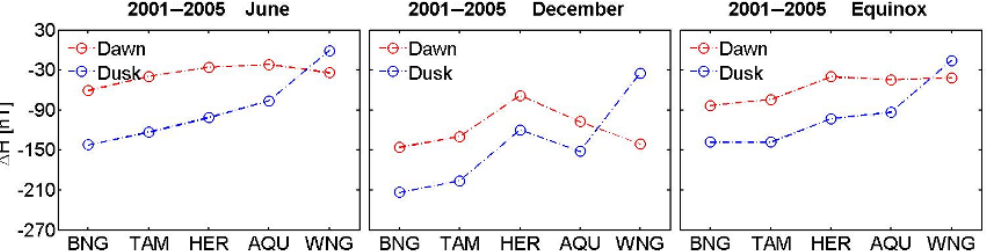
Figure 11. Comparison of the mean H component deflections between the dawn and dusk sectors at the five observatories separately for different seasons during active times (Kp > = 6).